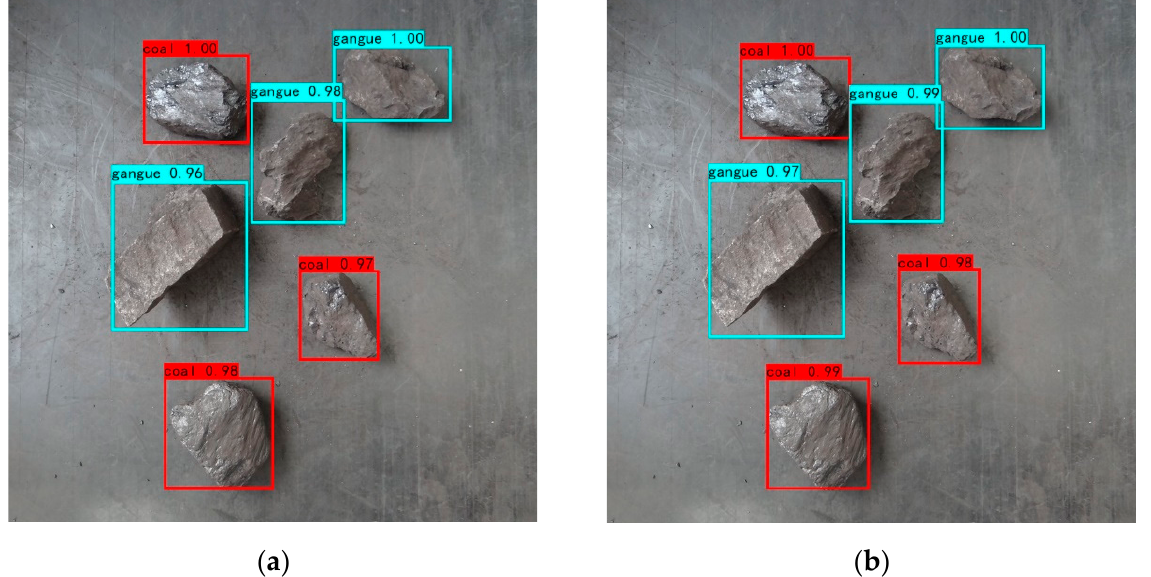
Figure 15. Comparison of the recognition results of coal gangue images on different platforms: ( a ) FPGA platform; ( b ) computer platform.